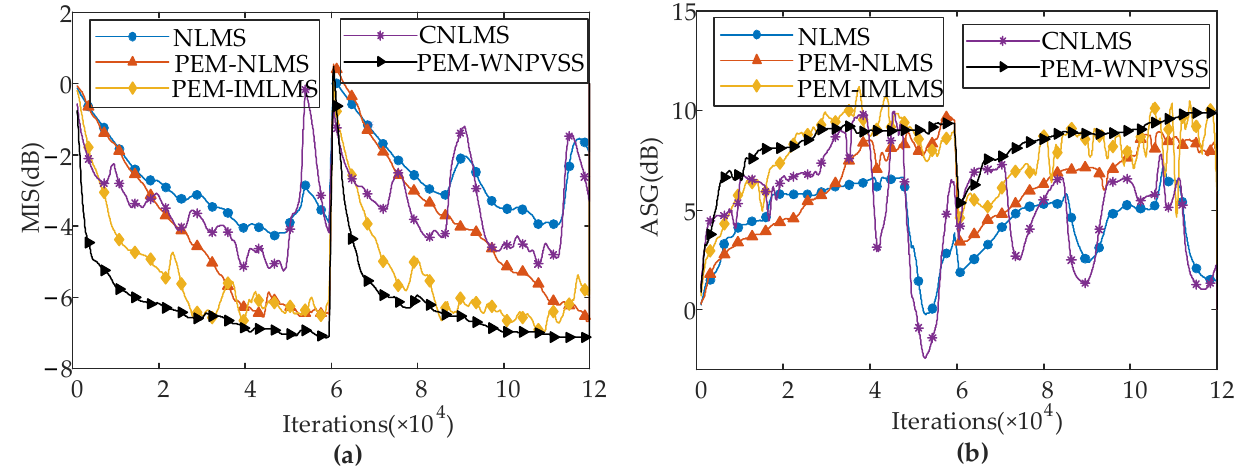
Figure 5. Performance of five algorithms with speech input: ( a ) MIS; ( b ) ASG.